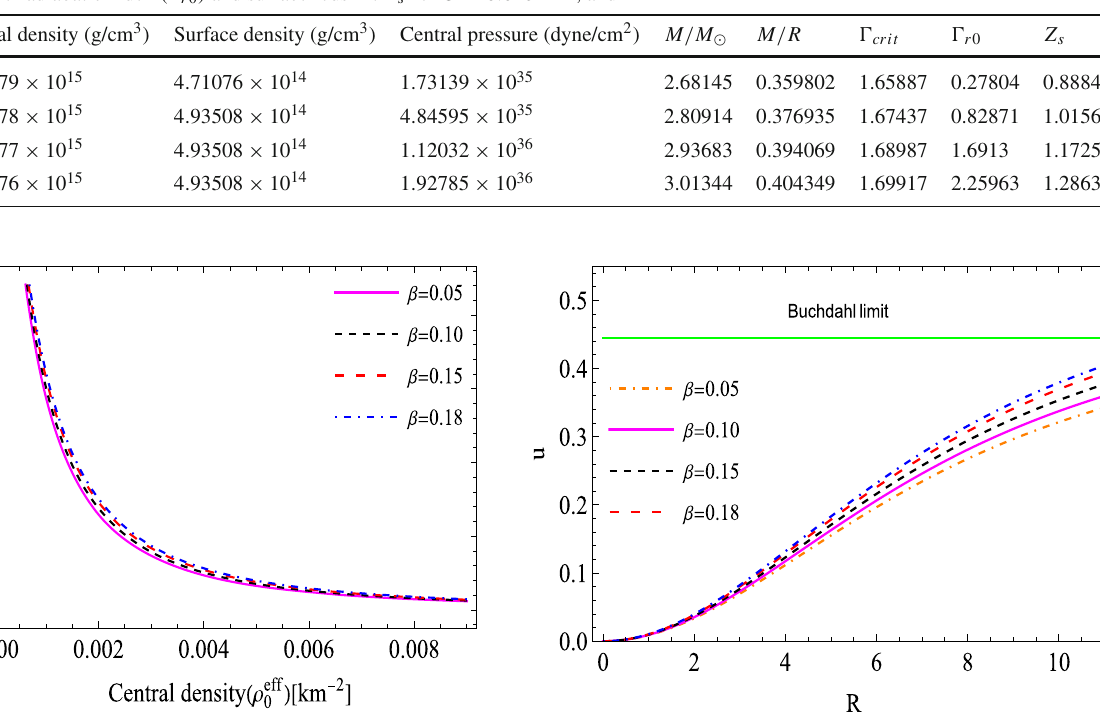
Table 1 Numerical values of the physical parameters such as: the central density, surface density, central pressure, mass ( M / M (cid:9) ), M / R , (cid:20) crit , central value of adiabatic index ((cid:20) r 0 ) and surface redshift Z s for C = 0 . 018 km 2 , and R = 11 km